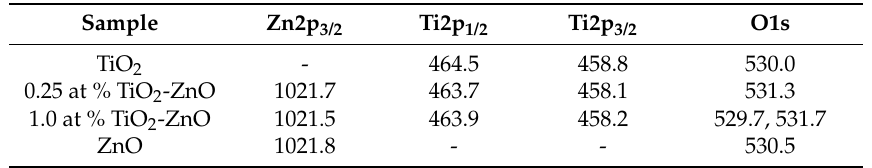
Figure 8. XPS spectra Ti2p of TiO 2 , 0.25 at % TiO 2 -ZnO, and 1.0 at % TiO 2 -ZnO. Table 4. Summary of XPS spectra of Zn2p 3/2 , Ti2p 1/2 , Ti2p 3/2 , and O1s for samples TiO 2 , 0.25 at % TiO 2 -ZnO, 1.0 at % TiO 2 -ZnO, and ZnO.